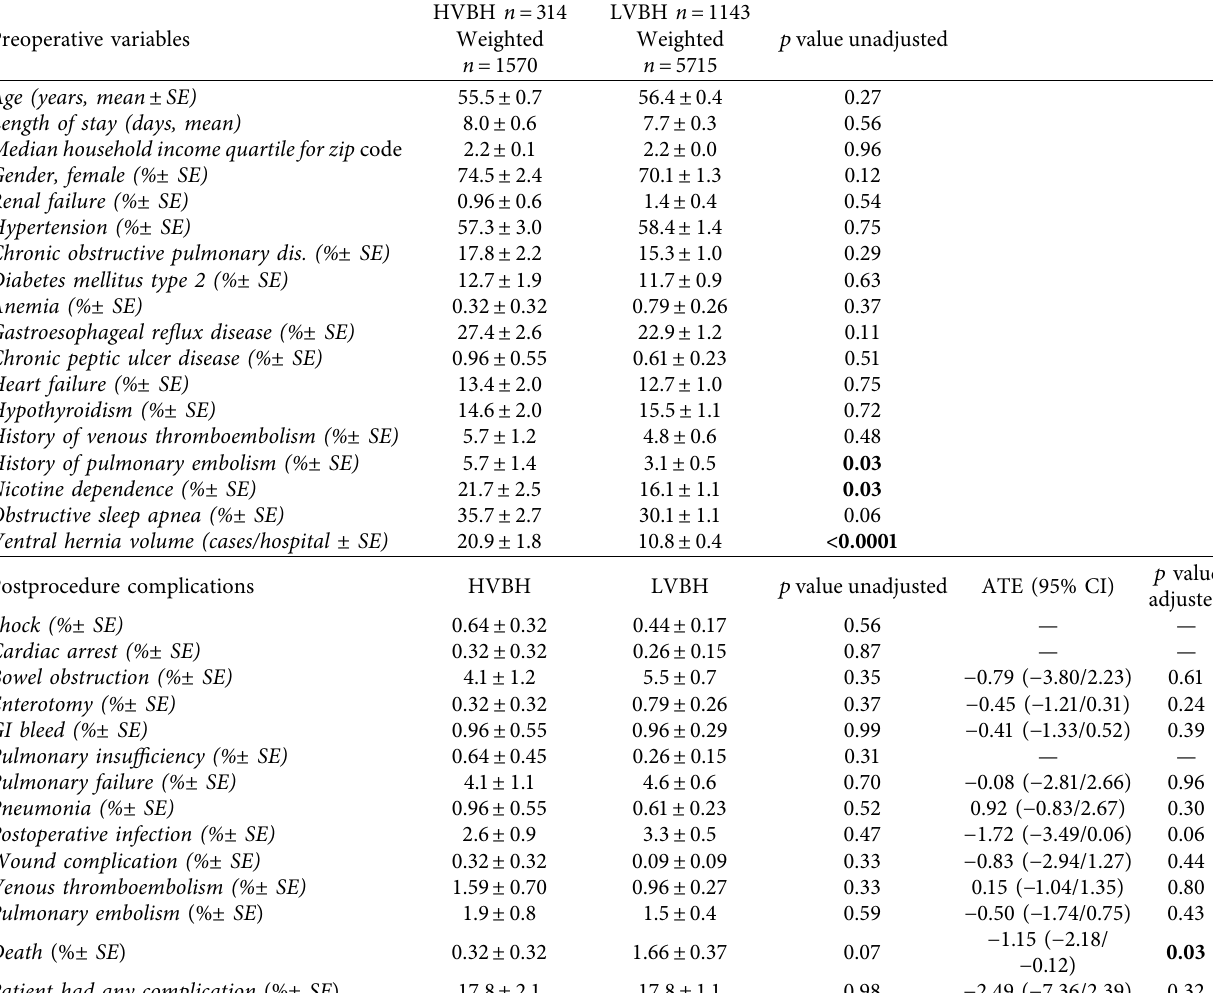
Table 5: Preoperative comorbidities and postoperative complications of patients with morbid obesity undergoing nonelective ventral hernia